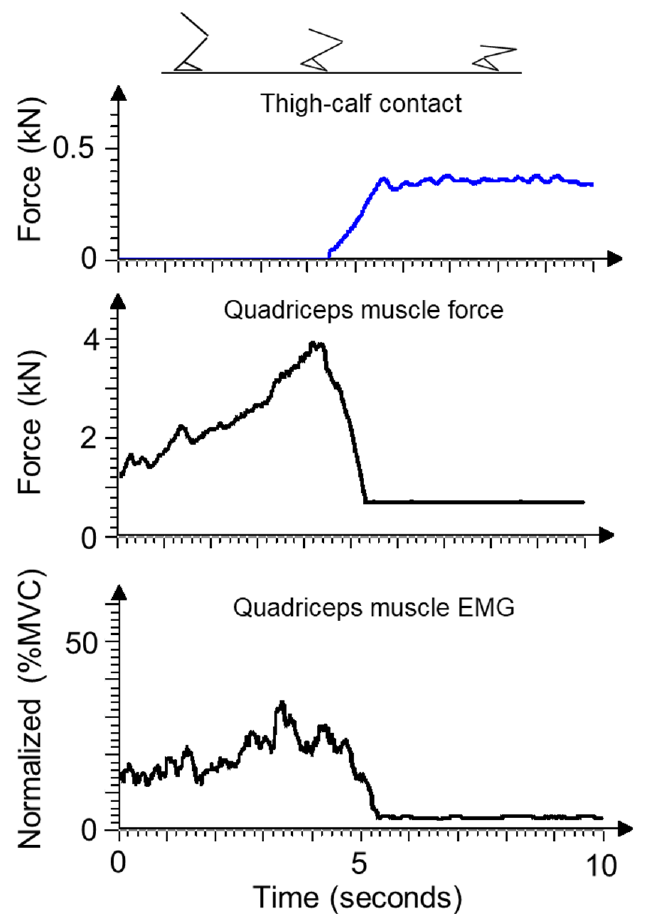
Figure 6. A typical example of the time histories of dynamic parameters and quadriceps muscle activity (%MVC) during lowering into a squat.